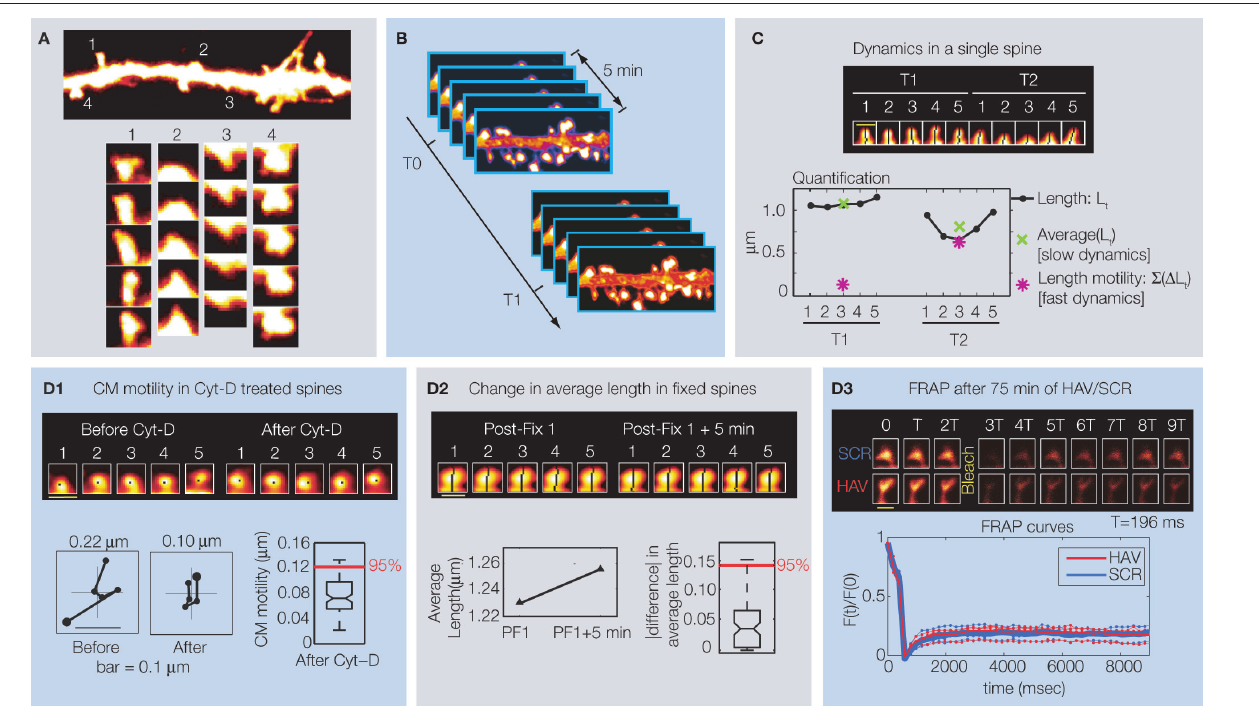
(D) Estimating the contribution of various sources of treatment-independent Figure 1 | (A) Example dendritic segment with spines. Time-lapse images noise to the measurement of center-of-mass motility (CM motility, D1 ), change (every 2 min) of nearby spines showing different kinds of motility – (1) change in in average length (D2) , and the contribution of treatment-dependent noise (D3) . position and shape (2) increase in length, (3) decrease in length, and (4) change FRAP is fluorescence recovery after photobleaching. T0 (baseline) = − 10 min, in position. (B) Image acquisition protocol to study dynamics at two timescales. T1 = 75 min, and T2 = 180 min. The pseudo-coloring of dendrites and spines in Each timepoint consists of five stacks, each separated from the next by 1 min. all panels indicates the intensity of over-expressed EGFP, with white being the Timepoints themselves are T0, T1 … , separated by hours. (C) Time-lapse images highest pixel intensity and black the lowest. All panels modified from Mysore of example spine showing instantaneous length (L ), average length (slow t et al. dynamics), and length motility (fast dynamics) measured at two timepoints.